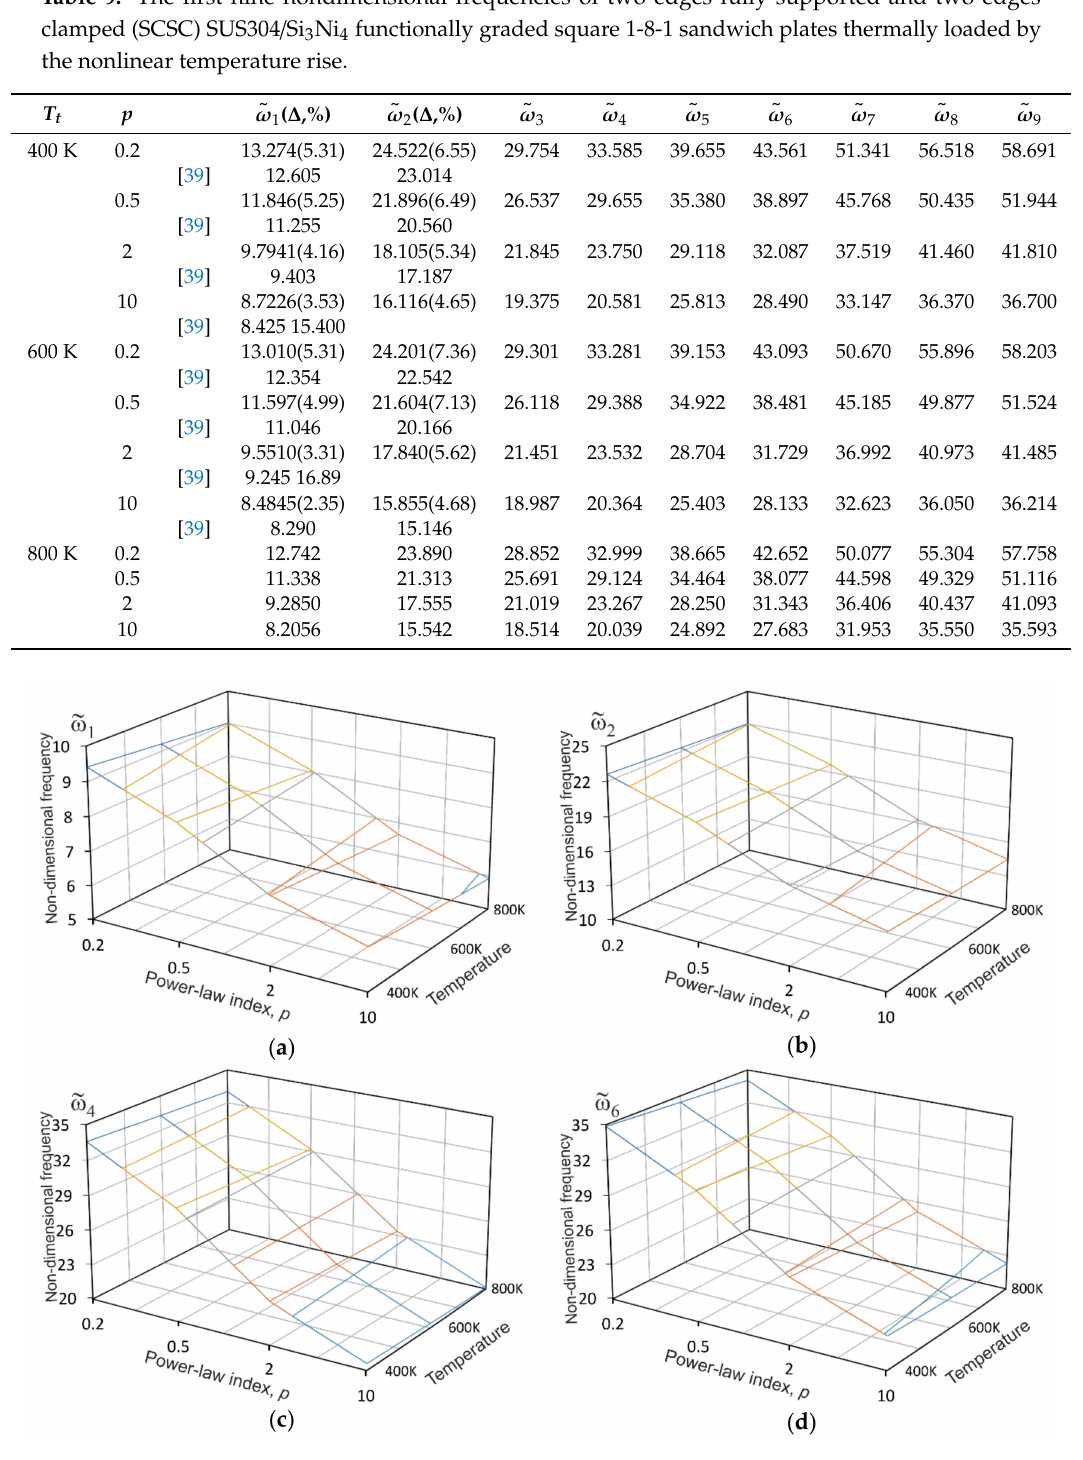
Table 9. The first nine nondimensional frequencies of two edges fully supported and two edges